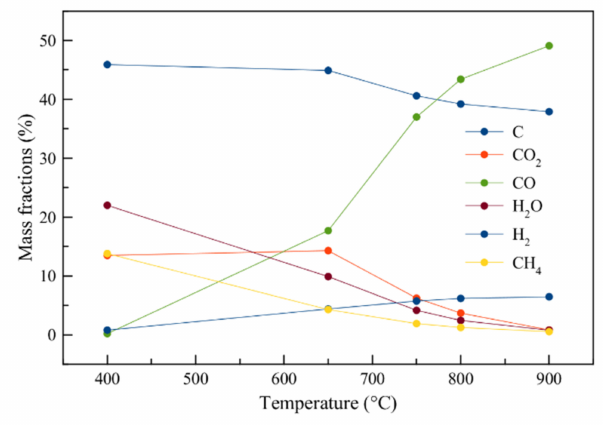
Figure 9. Aspen Plus results: main products from pyrolysis of hydrochar 180 °C.